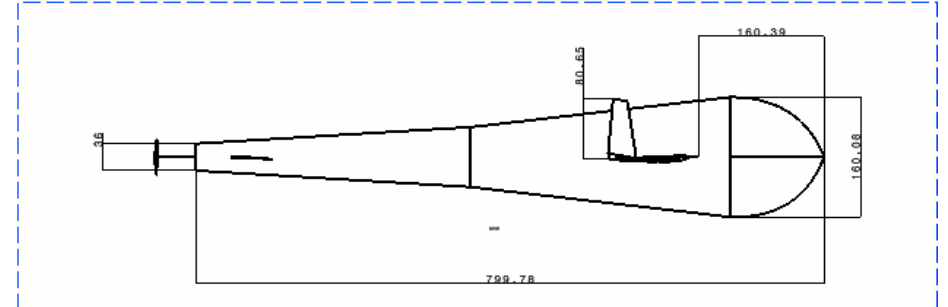
Figure 5. Design draft of the complete nature-based UAV—A typical view—1.